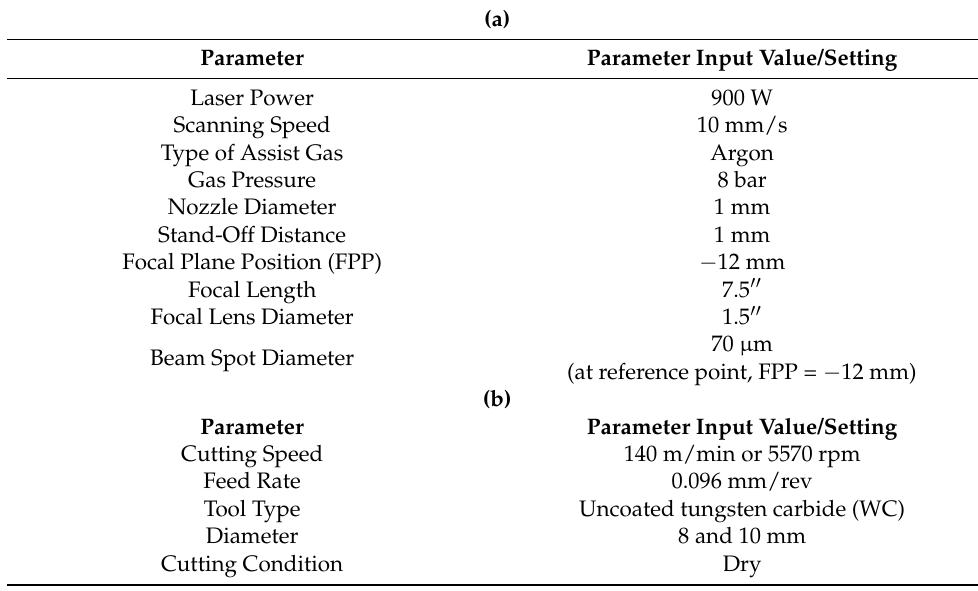
Table 2. The process parameters for sequential drilling: (a) pre-drill step–laser drilling; and (b) final step–mechanical